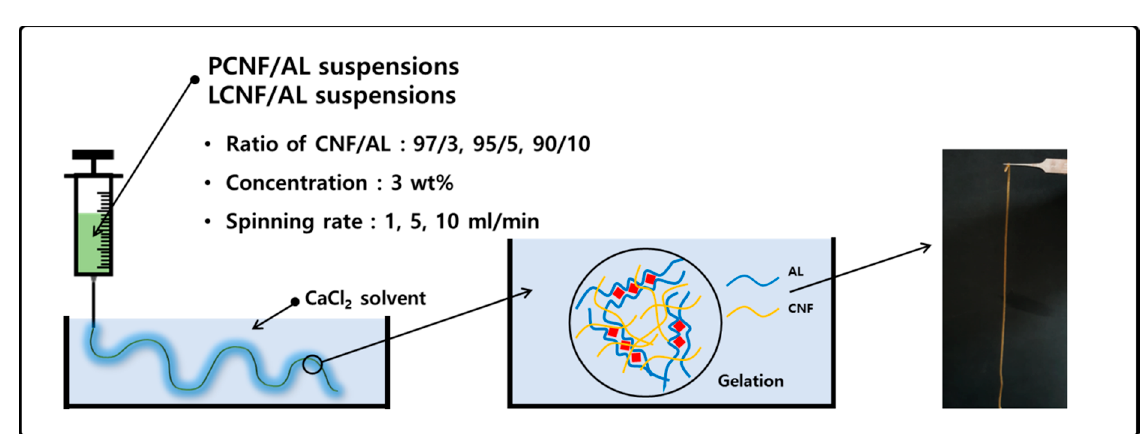
Figure 1. Scheme of composite filament preparation from pure cellulose nanofibril (PCNF)/alginate (AL) and lignocellulose nanofibril (LCNF)/AL suspension via wet spinning.